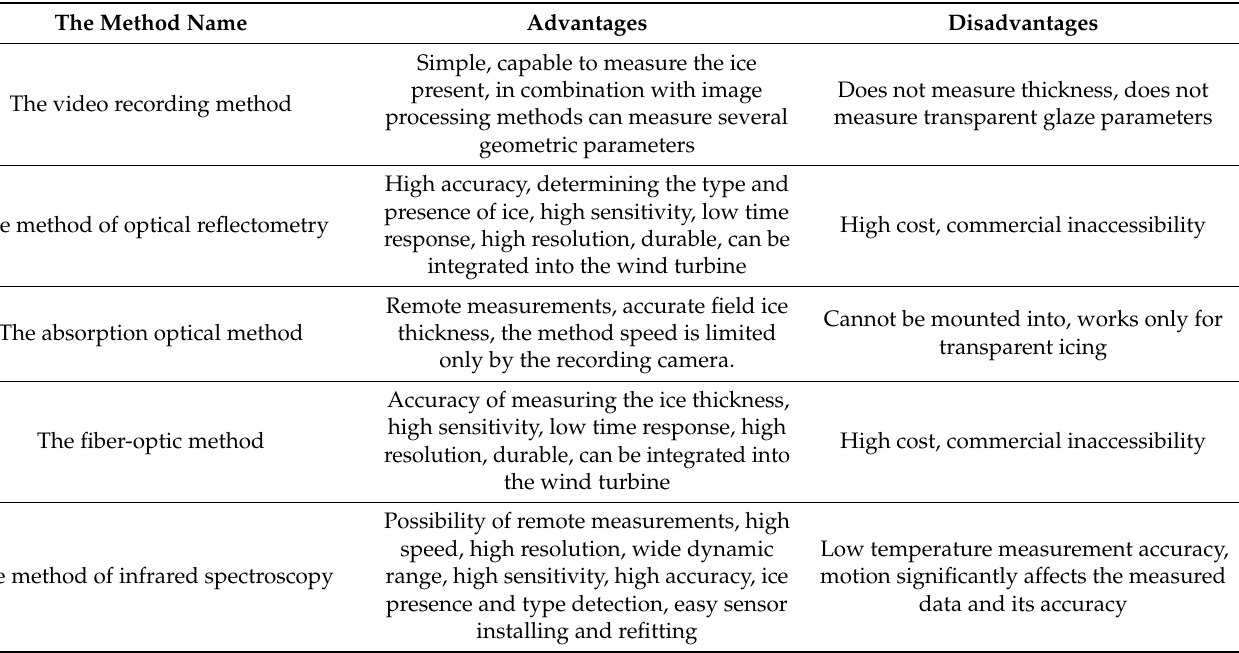
Table 1. The advantages and disadvantages of optical measurement